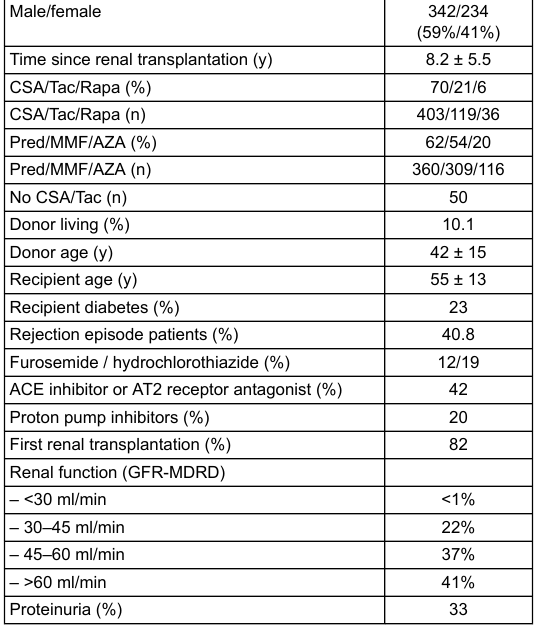
Table 1: Demographic data of the transplant population.